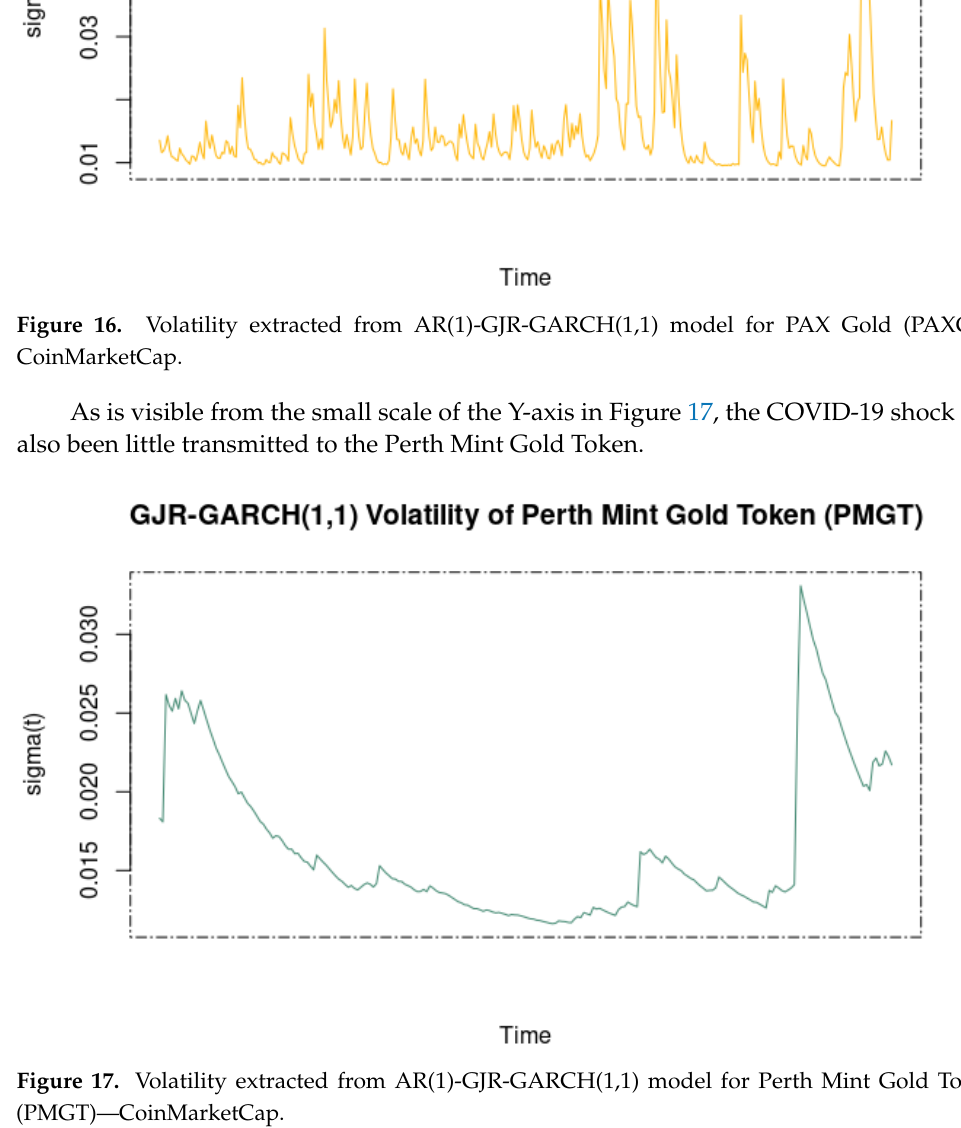
Figure 17. Volatility extracted from AR(1)-GJR-GARCH(1,1) model for Perth Mint Gold Token